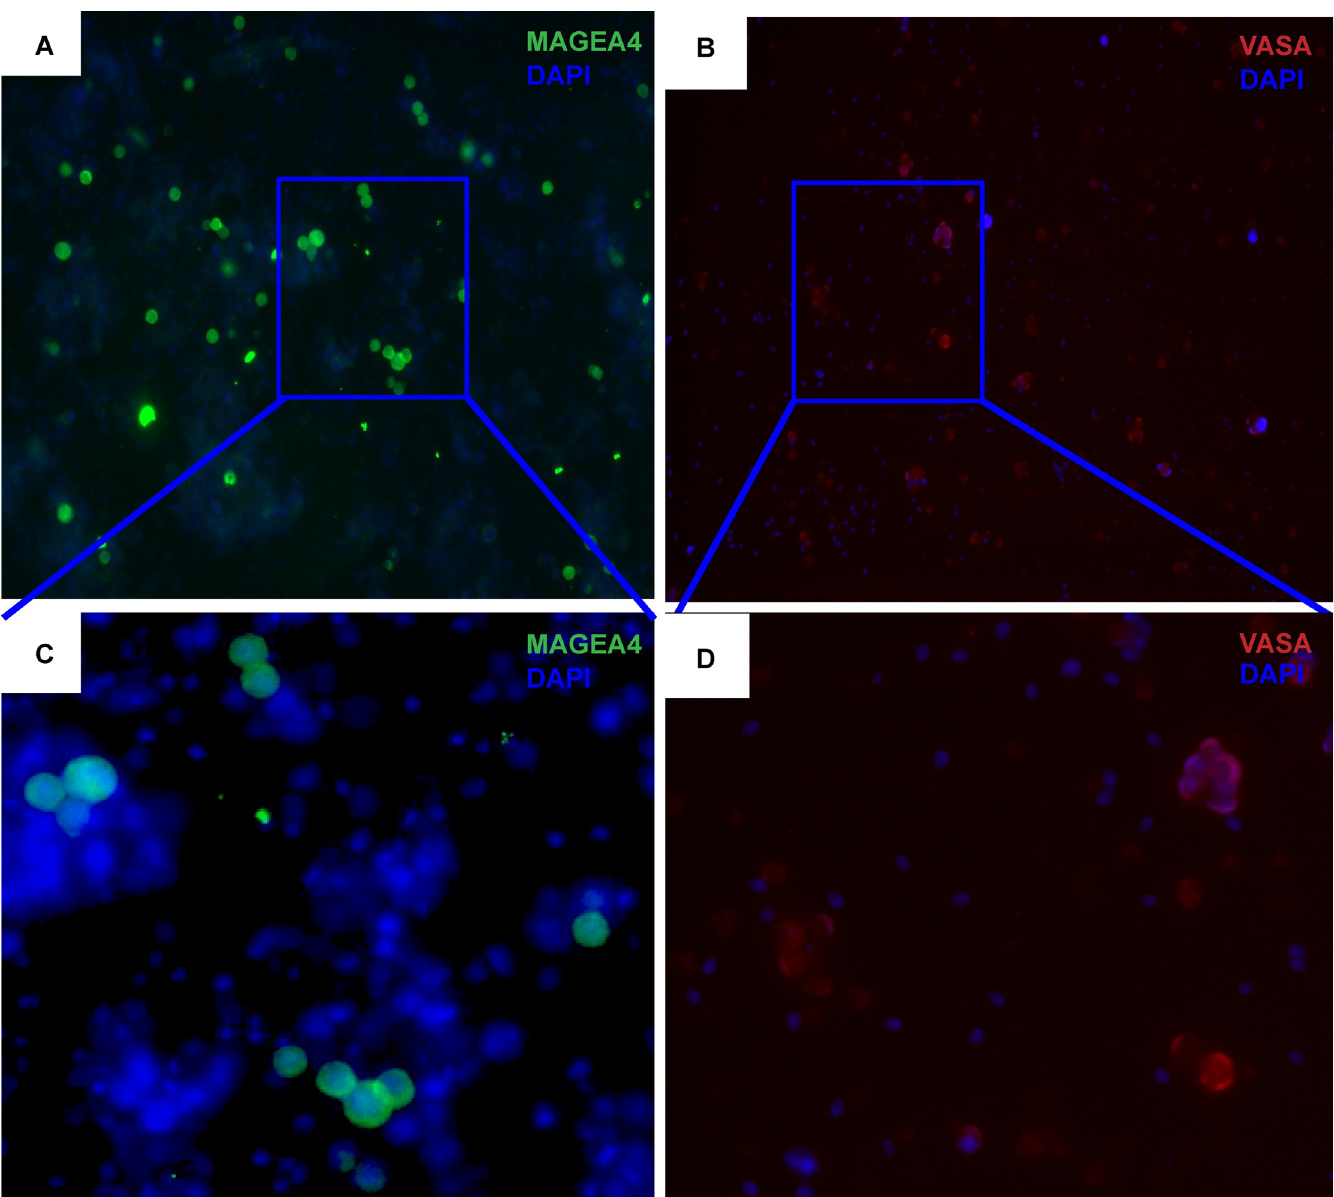
Fig 4. Adult macaque testicular cells cultured in SSC, PS and SM culture conditions were analyzed for expression of the germ cell markers MAGEA4 and VASA in vitro . Representative micrographs show cultured cells at day 14 exhibiting strong expression for gem cell markers MAGEA4 (A) and VASA (B) as shown (20x; with Dapi). Highlighted MAGEA4 (C) and VASA (D) labeled single cells and clusters of various sizes are shown (40x; with Dapi).